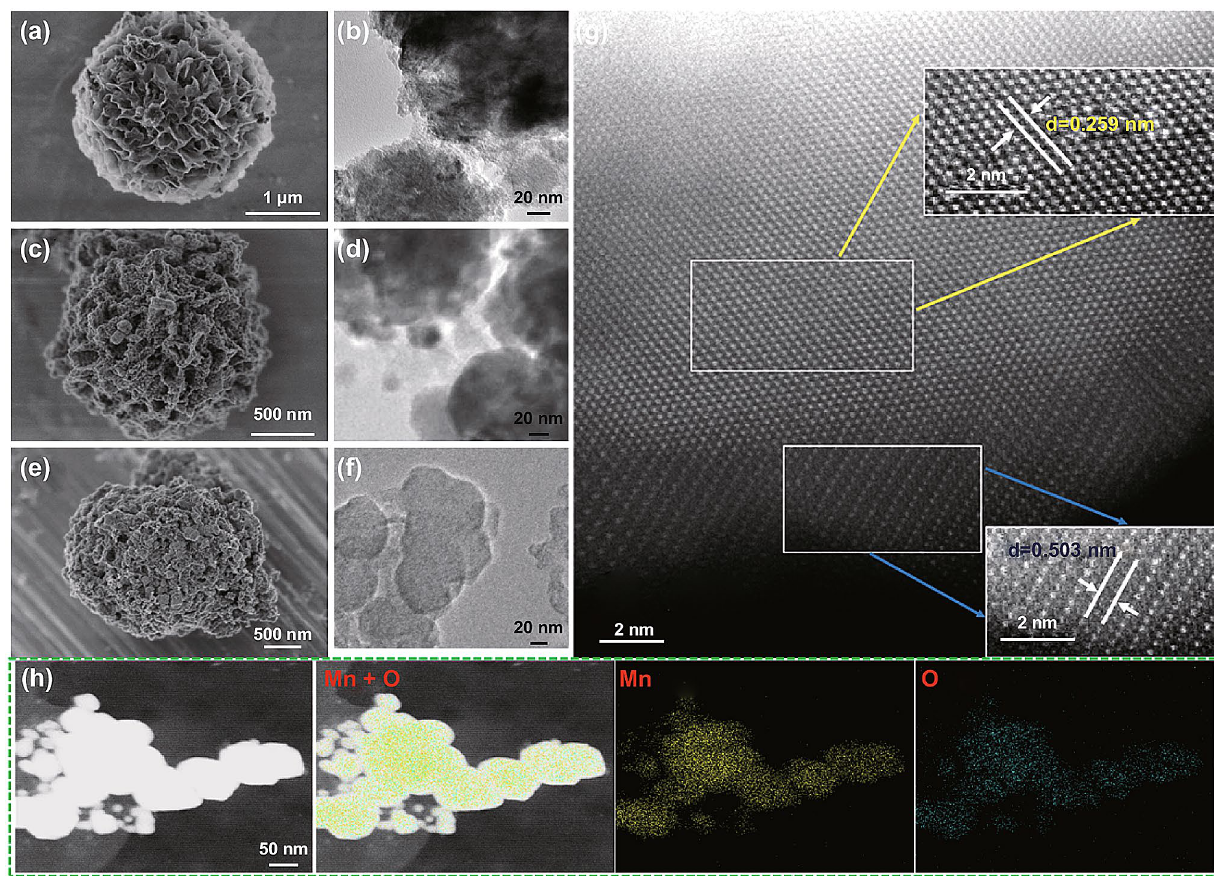
Fig. 2 a , c , e SEM and b , d , f TEM images of Mn 3 O 4 sample ( a , b ), original MnO-600 catalyst ( c , d ) and the correspondingly tested MnO-600 catalyst for 2000 ORR cycles ( e , f ). g , h Spherical aberration-corrected TEM ( g ) and TEM-EDS elemental mappings ( h ) images of